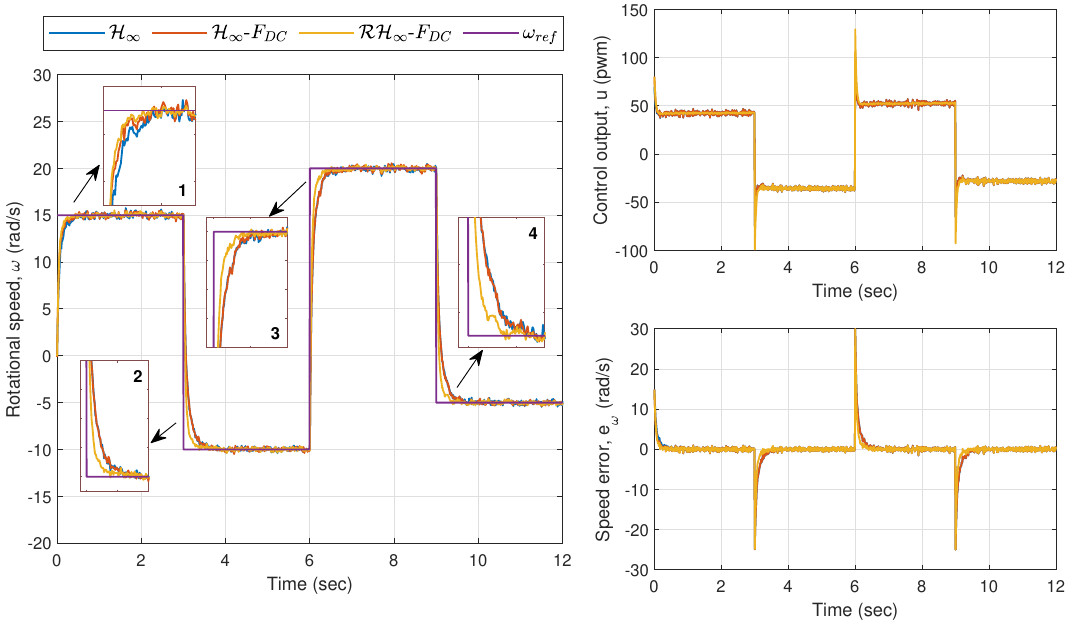
Figure 9. Exp. 1.1: Time responses of Motor A for a changing step input. A faster response is achieved via RH ∞ - F DC